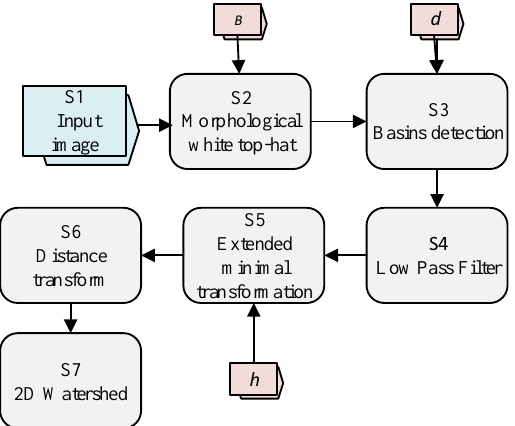
Figure 2. Flowchart of the proposed segmentation algorithm. As can be seen, three parameters B , h , d must be tuned to obtain the best possible result.